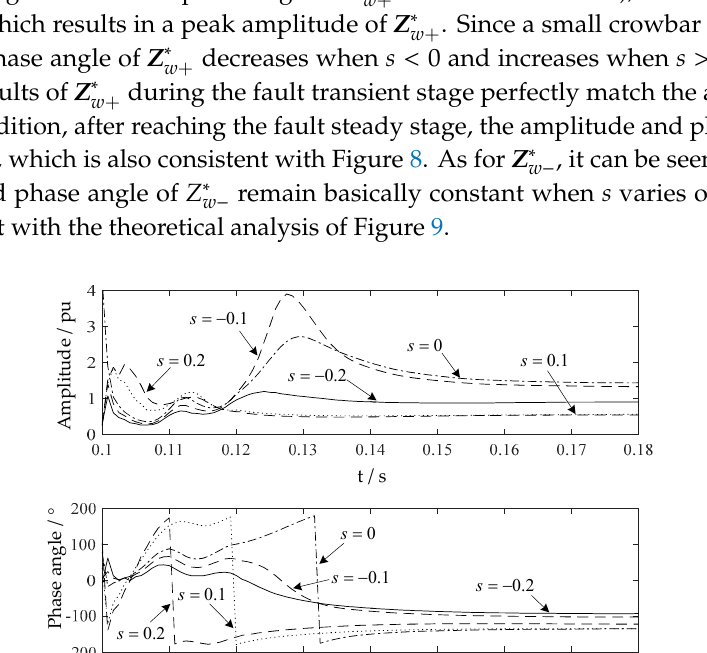
Figure 15. Characteristic simulation results of w